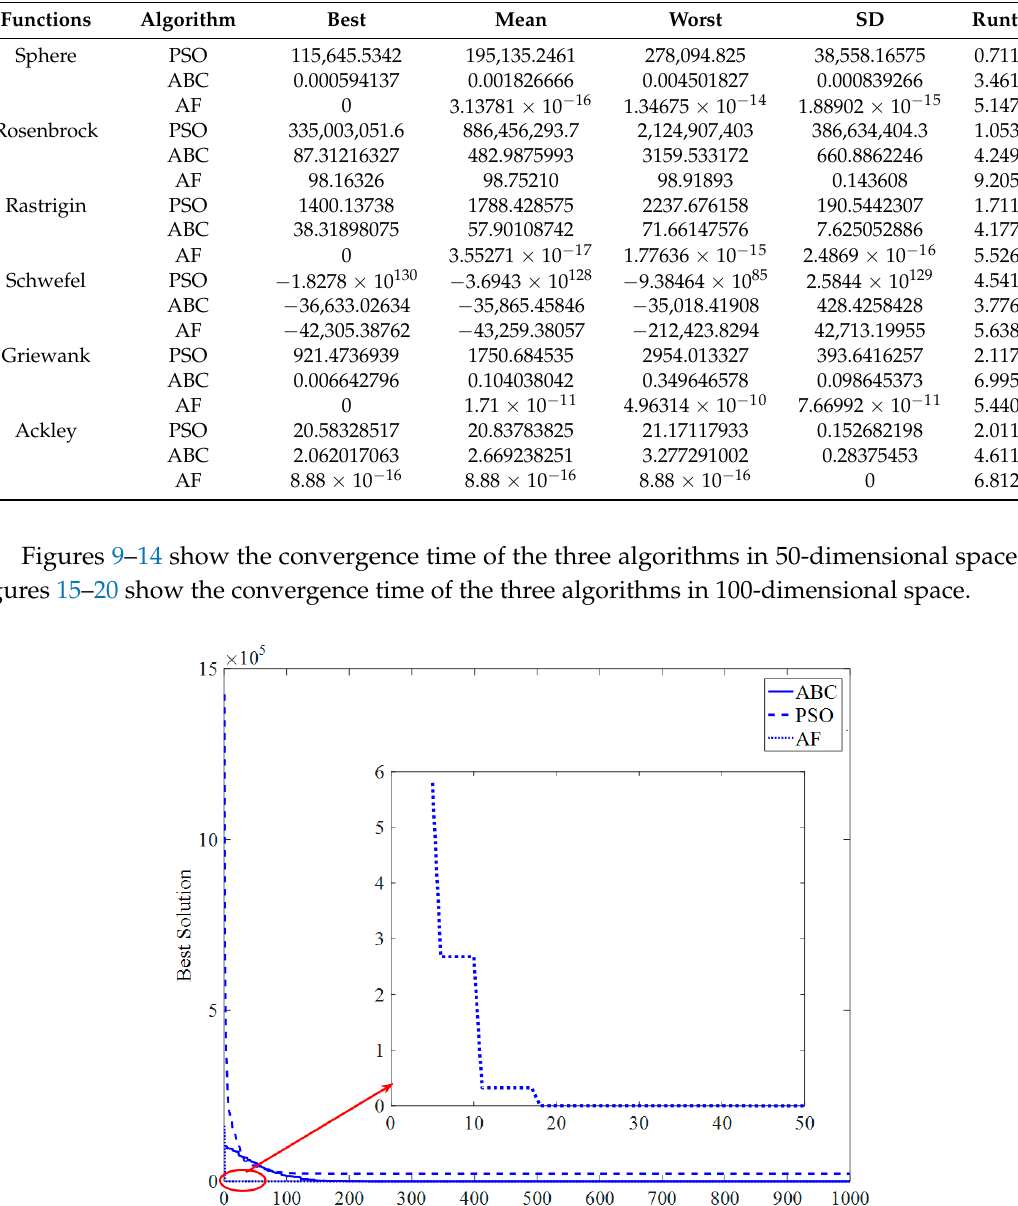
Figure 10. The convergence curve of the three algorithms for Rosenbrock function in 50-dimensional space. As shown in Figure 10, for Rosenbrock function, the PSO algorithm and ABC algorithm both converge at about 100 iterations, and the AF algorithm converges at about the 55th iteration.